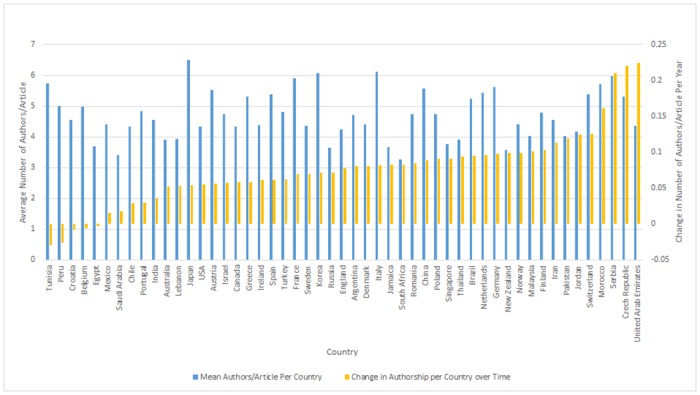
Mean Number of Authors/Article and Change of Authorship per Country.This is a double axis bar chart showing the mean number of authors/article per journal and the overall change in authorship per country over time. Countries were organized by change in authorship over time. Most countries analyzed show an increase in authorship over time with the exception of Tunisia (-0.029), Peru (-0.026), Croatia (-0.008), Belgium (-0.006) and Egypt (-0.003).